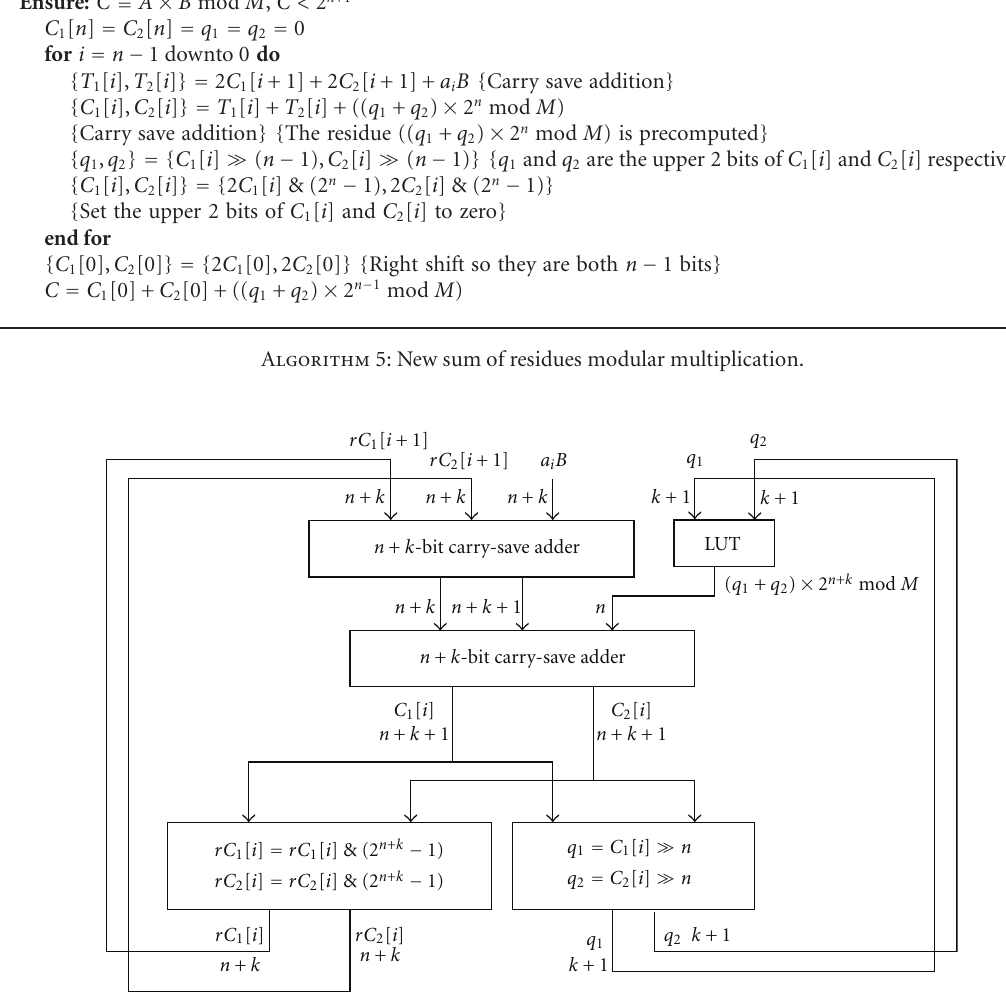
Figure 6: New higher-radix sum of residues modular multiplier